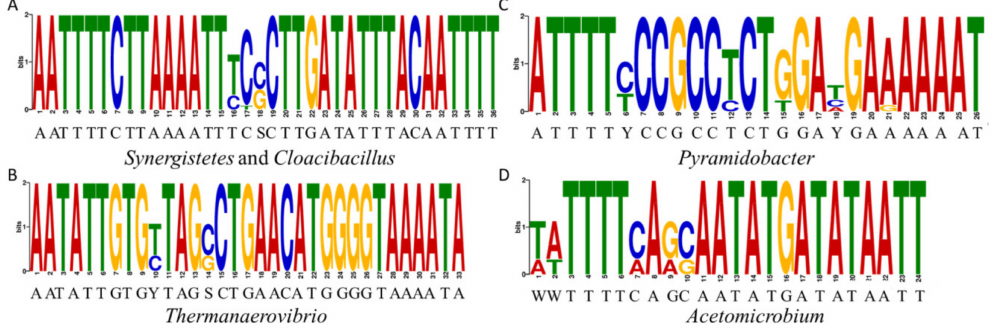
Figure 3. Motif logos representing the binding sites of the CodY-like proteins for five genera in the phylum Synergistetes. The logos were generated by the MEME function of the MEME suite. All 40 core binding sequences of the CodY-like protein listed in Table S5 were used to analyze the common motifs in Synergistes and Cloacibacillus ( A ), Thermanaerovibrio ( B ), Pyramidobacter ( C ) and Acetomicrobium ( D